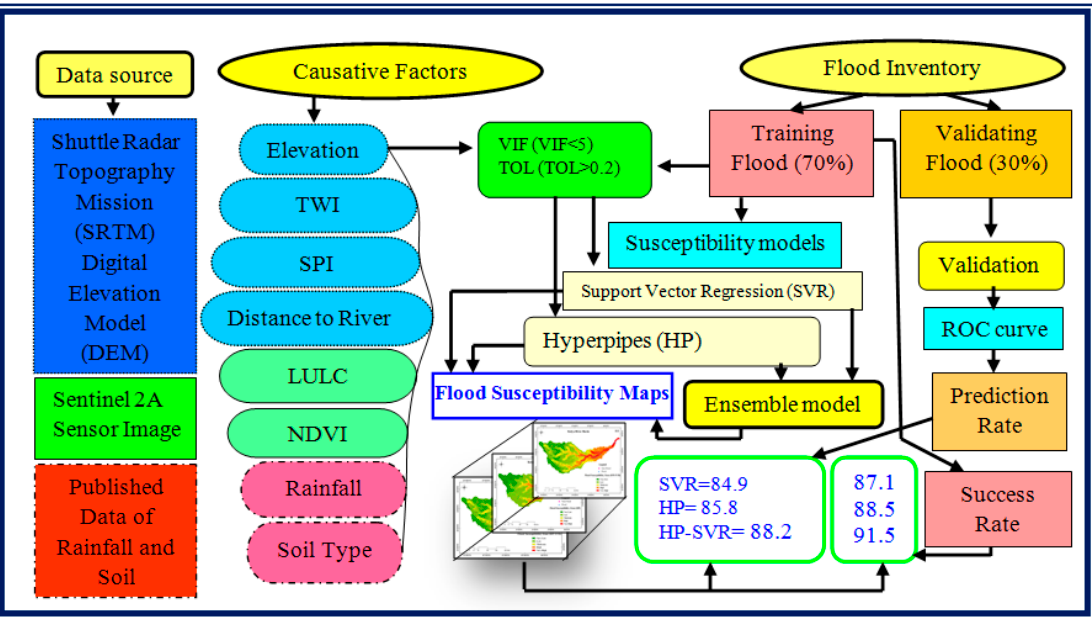
Figure 2. Methodological flow chart of flood susceptibility (FS)